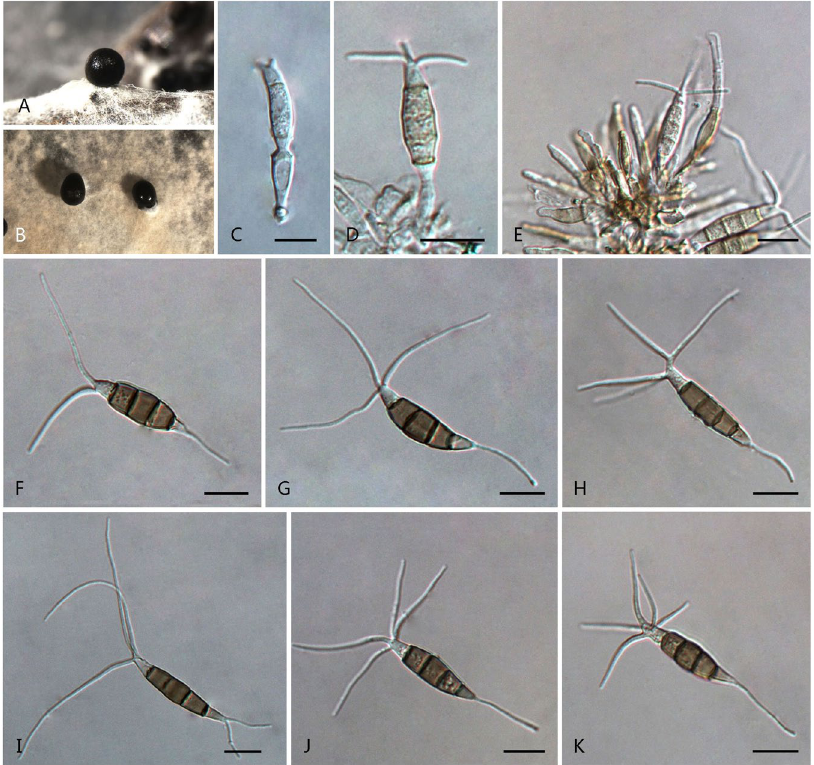
Figure 8. Pestalotiopsis dilucida (from ex-holotype culture CGMCC 3.18154 ( = LC3232)). ( A ) Conidioma sporulating on pine needle. ( B) Conidiomata on PDA. ( C–E ) Conidiogenous cells and conidia. ( F–K ) Conidia. Scale bars = 10 μ